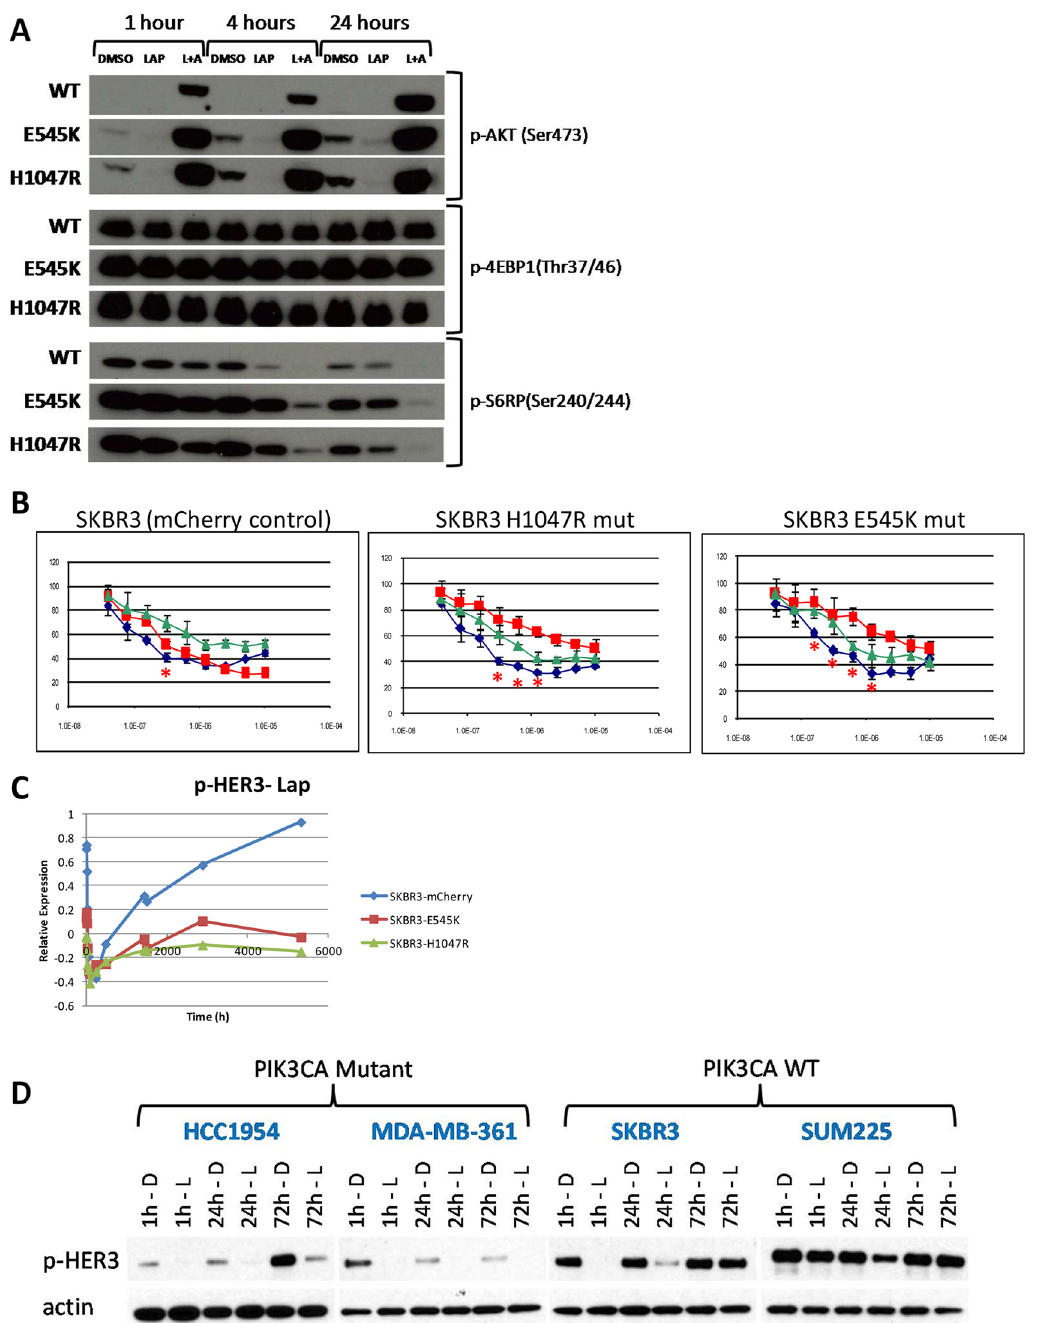
Fig 5. A . Western blots of SKBR3 cells transduced with retroviruses encoding either PIK3CA H1047R or E545K mutant alleles or control vector (mCherry). Mutant transduced lines show increased levels of p-AKT and p-S6RP at baseline, and diminished response to lapatinib alone as measured by p-S6RP levels. Note that mutation has little effect on p-4EBP1 levels. B . Growth curves for control, E545K mutant, or H1047R mutant transduced SKBR3 cells treated with lapatinib (red), GSK690693 (green), or a combination of the two (blue). Introduction of mutations results in increased resistance to lapatinib and synergistic interactions between lapatinib and GSK690693 (doses with significant synergy are marked with a red asterisk), indicating a functional role for PIK3CA mutations in determining synergistic response to this combination. C . Analysis of RPPA time course data shows blunted recovery of p-HER3 levels in SKBR3 cells harboring PIK3CA mutations, while the control cell line shows the expected hyper-phosphorylation following lapatinib treatment. D . Western blotting confirms the lack of recovery in non-engineered cells lines with PIK3CA mutations compared to PIK3CA wild type lines.